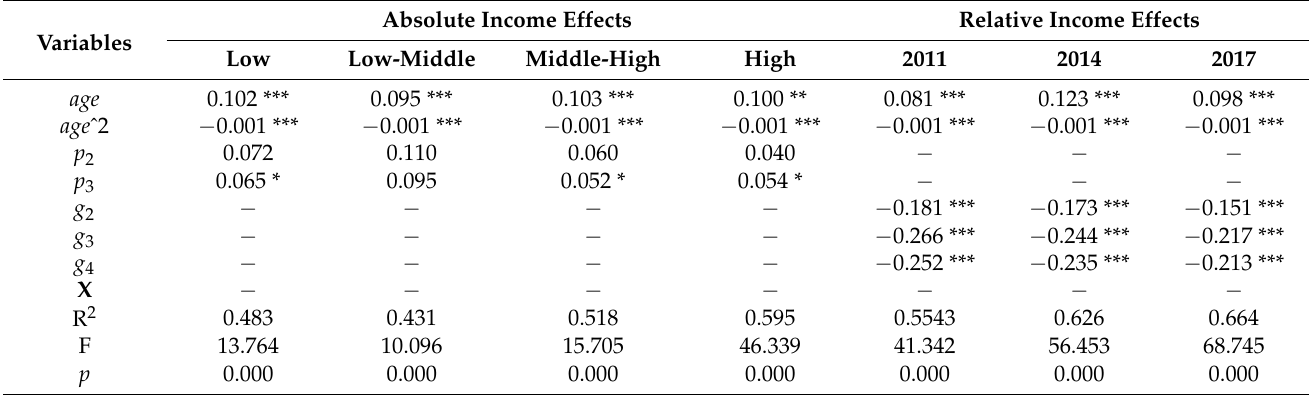
Table 4. Test of absolute income and relative income